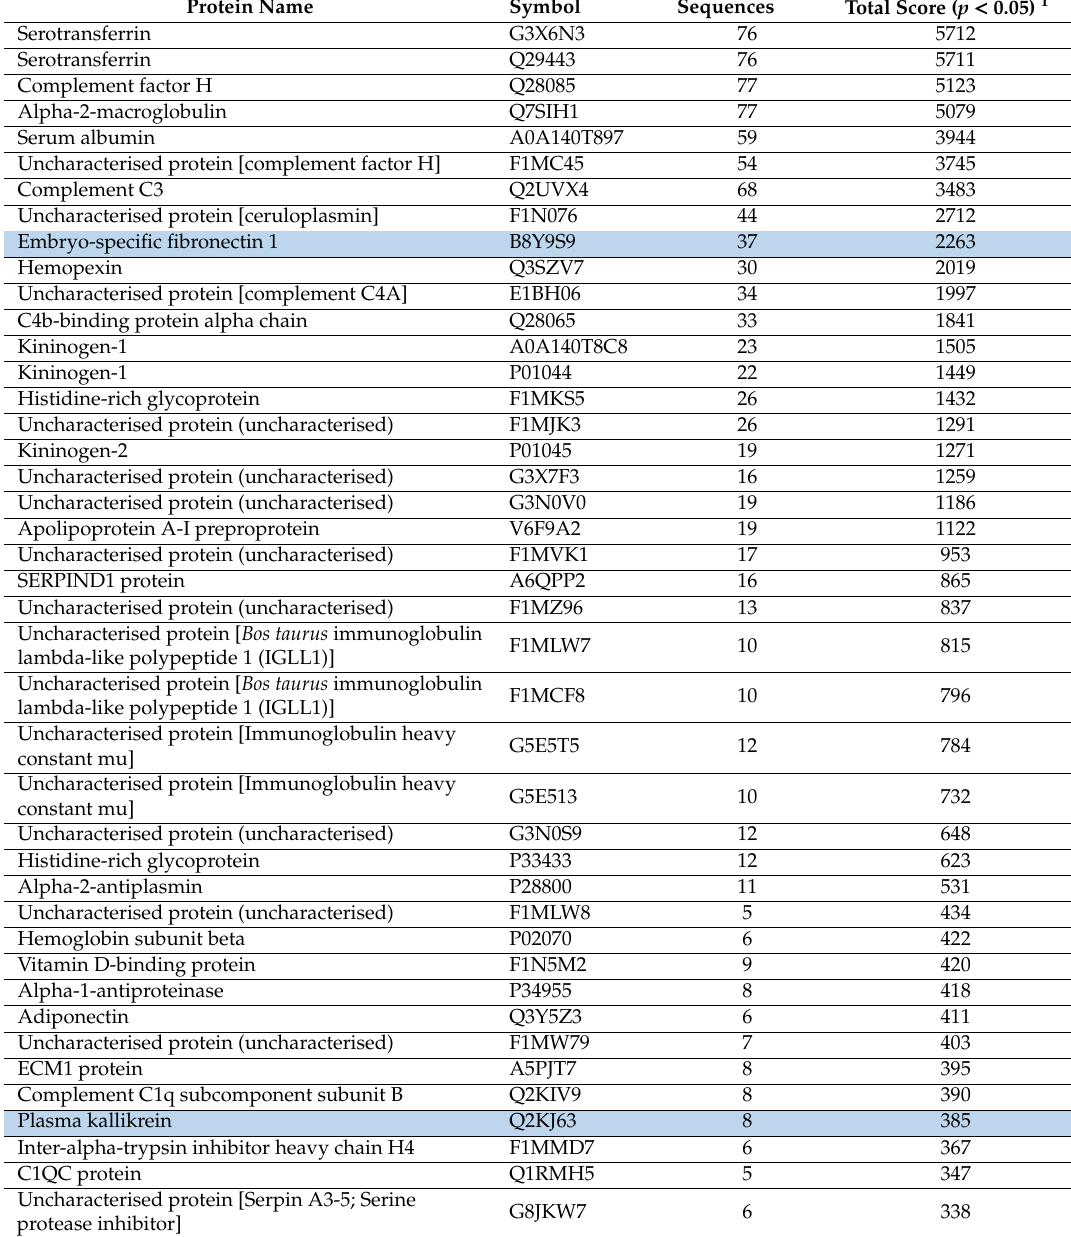
Table 1. Deiminated proteins in bovine serum ( Bos taurus ), as identified by F95-enrichment and LC-MS / MS analysis. Deiminated proteins from serum were isolated by immunoprecipitation using the pan-deimination F95 antibody. The resulting F95-enriched eluate was then analysed by LC-MS / MS and peak list files submitted to Mascot. Bos taurus species-specific peptide sequence hits are listed, showing number of sequences for protein hits and total score. Blue highlighted rows indicate protein hits identified in whole sera only. Uncharacterised proteins based on LC-MS / MS search were further confirmed in STRING, based on the protein symbol, and protein identification from STRING, where retrieved, is shown in brackets ([]). For further full LC-MS / MS analysis of all protein hits see Supplementary Table